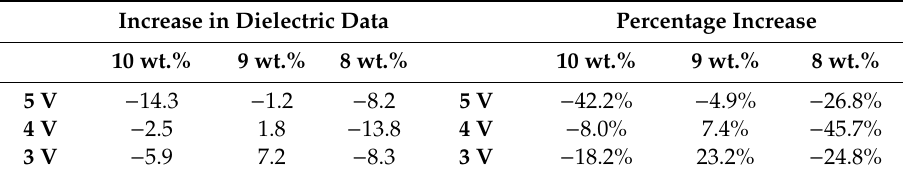
Table 4. Improvement in dielectric constants in improved system.